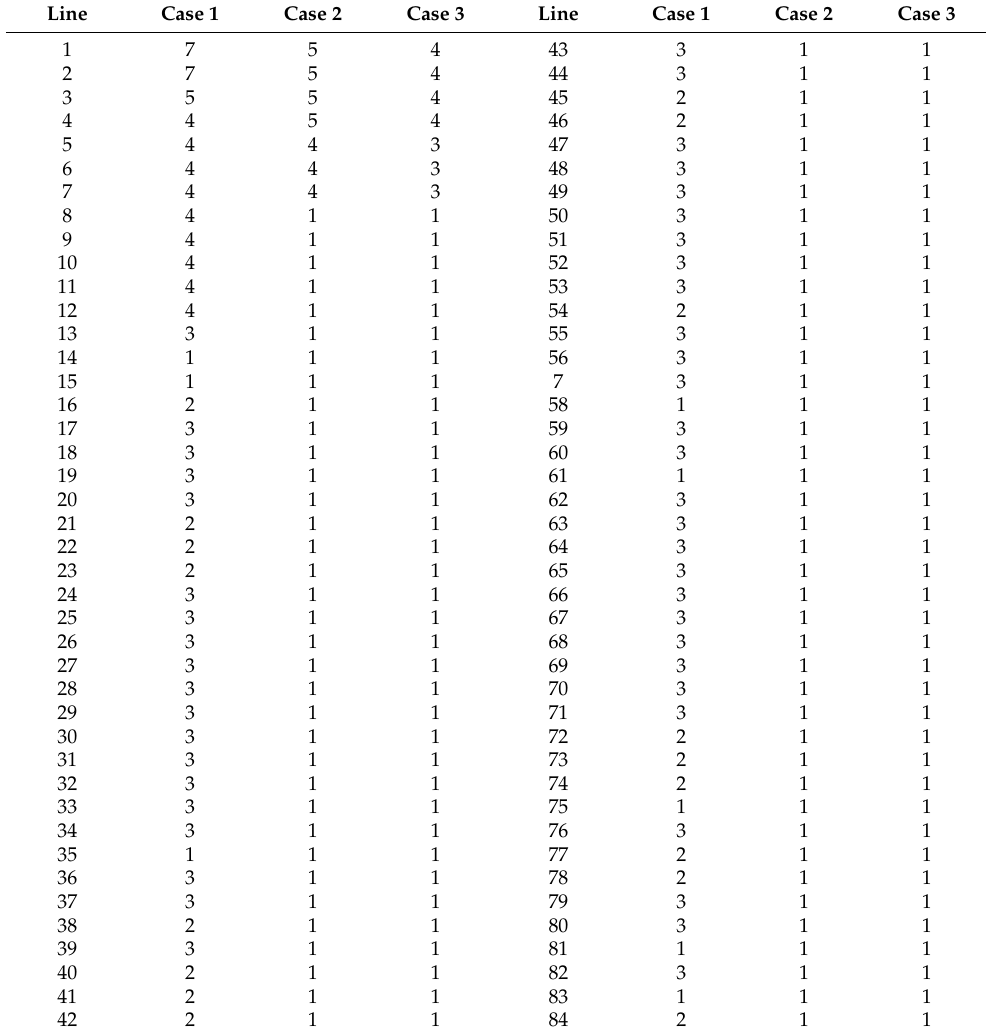
Table 16. Conductors selected for the IEEE 85-bus grid at each operative scenario.